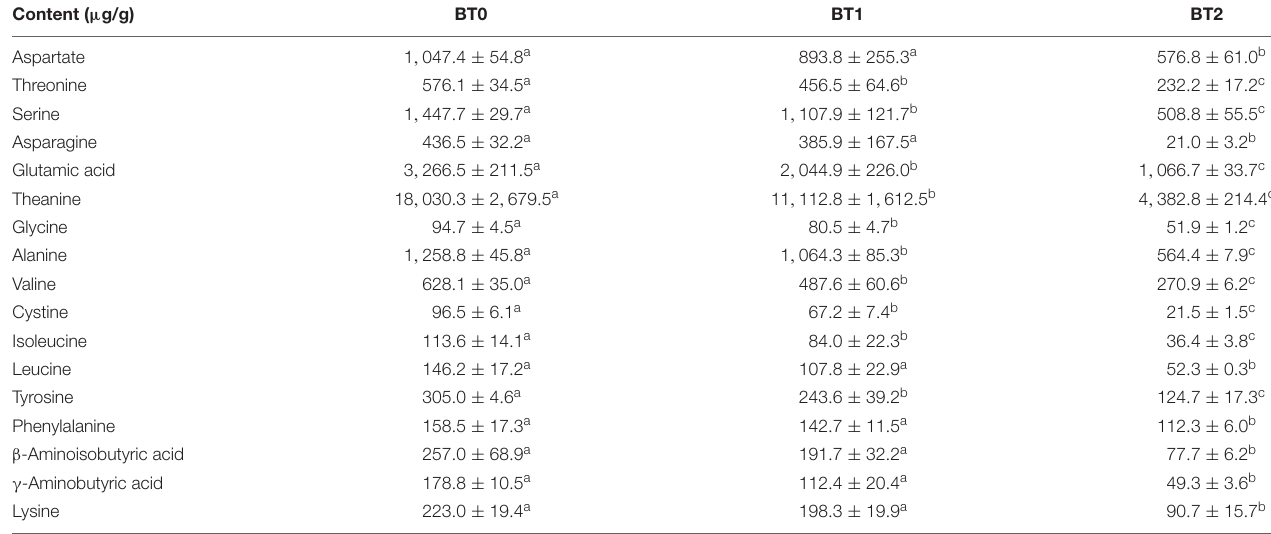
TABLE 3 | The contents of free amino acid components in jade (BT0), medium-baked (BT1), and deep-baked (BT2) Tieguanyin oolong teas. Content ( µ g/g) BT0 BT1 BT2